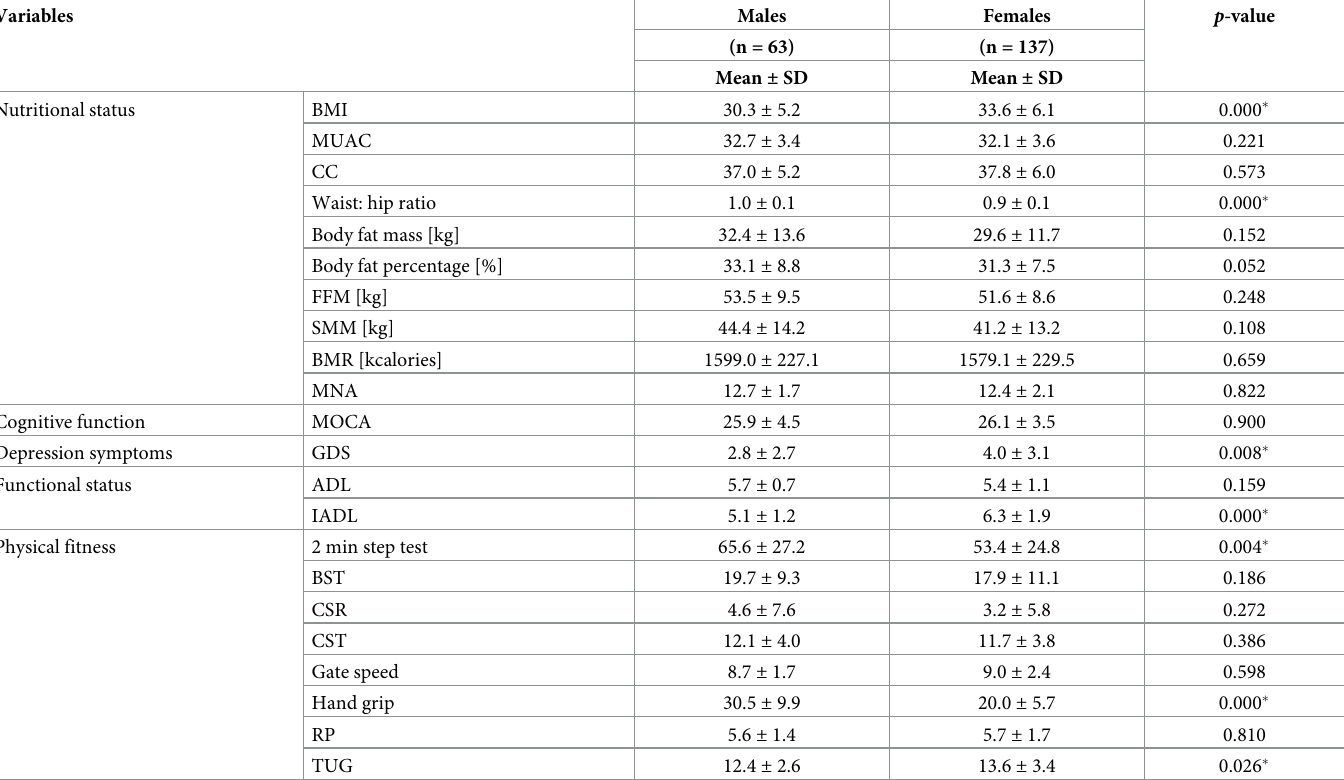
Table 2. Participants’ nutritional status, cognitive and physical function profile according to gender.